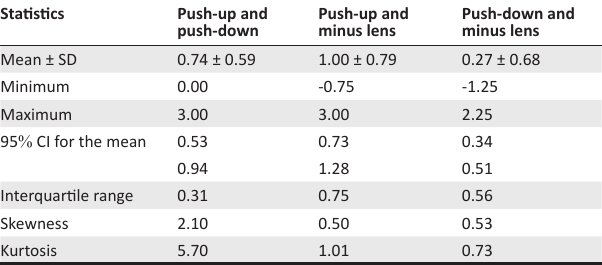
The solid horizontal line indicates the mean difference between the two measurements, and the horizontal dashed lines represent the 95 % limit of agreement (mean ± 1.96 s.d.). The 95 % limits of agreement for the measurements are within 1.40 D. FIGURE 6: A Bland–Altman plot of differences versus means for the push-up and push-down methods. The y -axis shows the difference between the two paired measurements (push-up – push-down) and the x -axis represents the mean of these measures [(push-up + TABLE 3: Mean differences between the values of the amplitudes of accommodation obtained using the three methods for measurement of amplitude of accommodation.